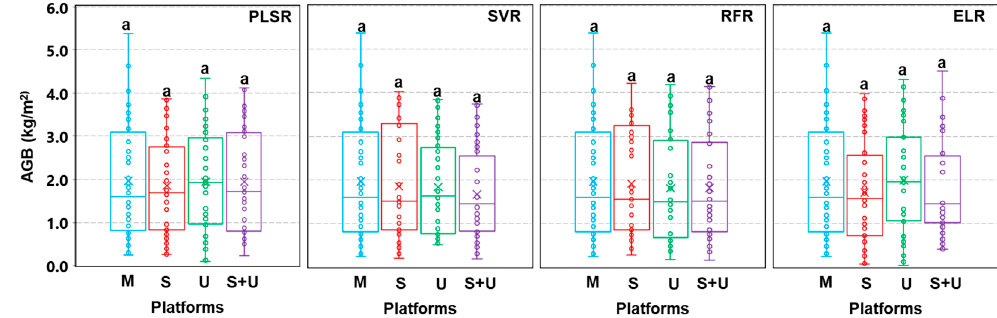
Figure 5. Boxplot for measured (M) and predicted AGB using satellite (S), UAV (U), as well as combined satellite and UAV (S + U), data from each model. ANOVA was carried out, and the letter ‘a’ on the bars indicate no significant differences according to the HSD Tukey's test ( α = 0.05).